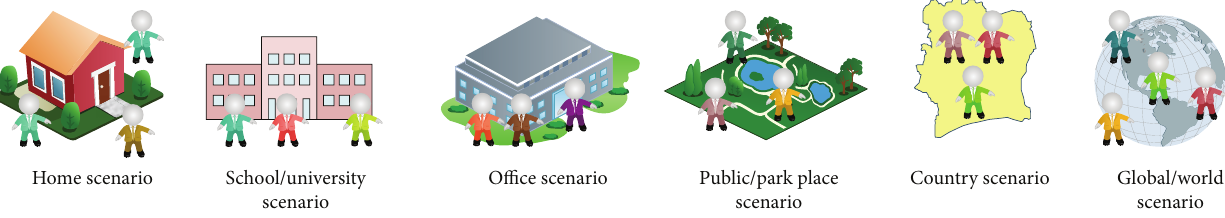
Figure 6: Real world ad hoc networking establishment scenarios.